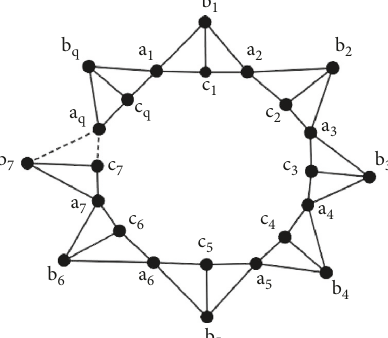
Figure 1: Double sunflower network [ DSF ]